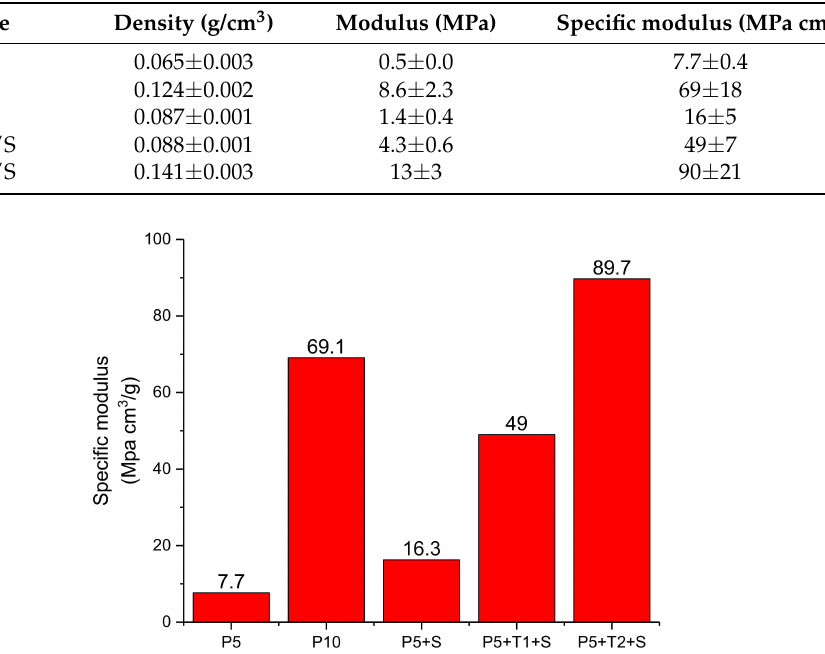
Table 2. Densities and compression properties of PVA aerogels, PVA/NaOH aerogel and PVA/TA/NaOH.